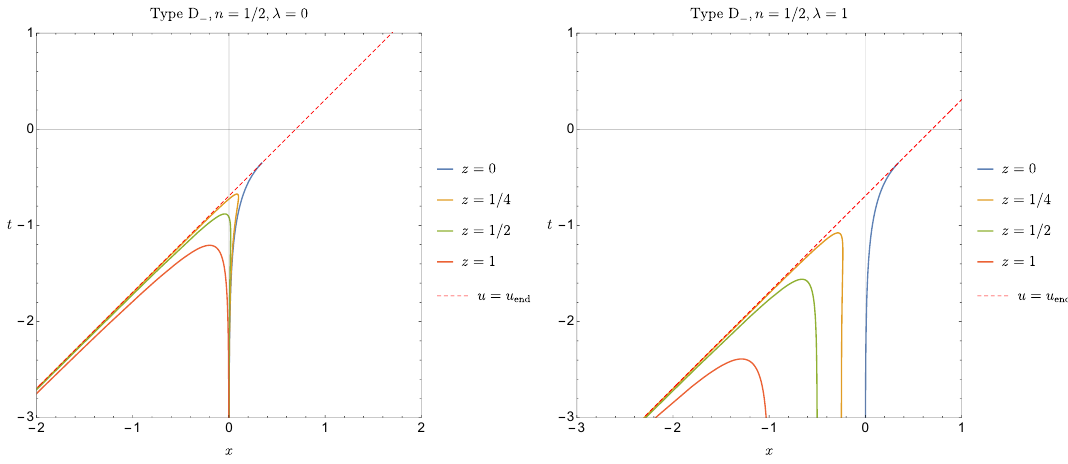
Figure 22 . Profiles of the brane Q associated with mirrors of type D − in coordinates ( t, x ) for various z . The mapping functions are given in eq.